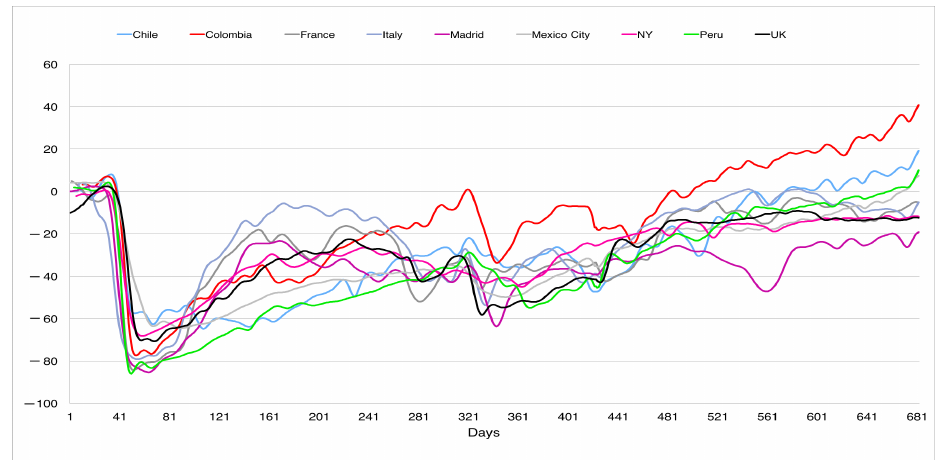
Figure 9. Social distancing in different countries’ cities between 4 April 2020 and 16 December 2021.